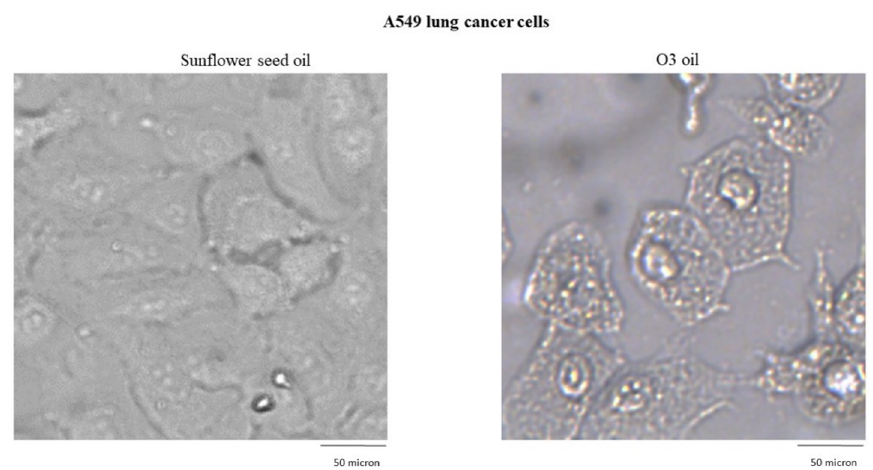
Figure 5. HOO penetration inside A549 lung cancer cells, as traced by microscope light scattering.